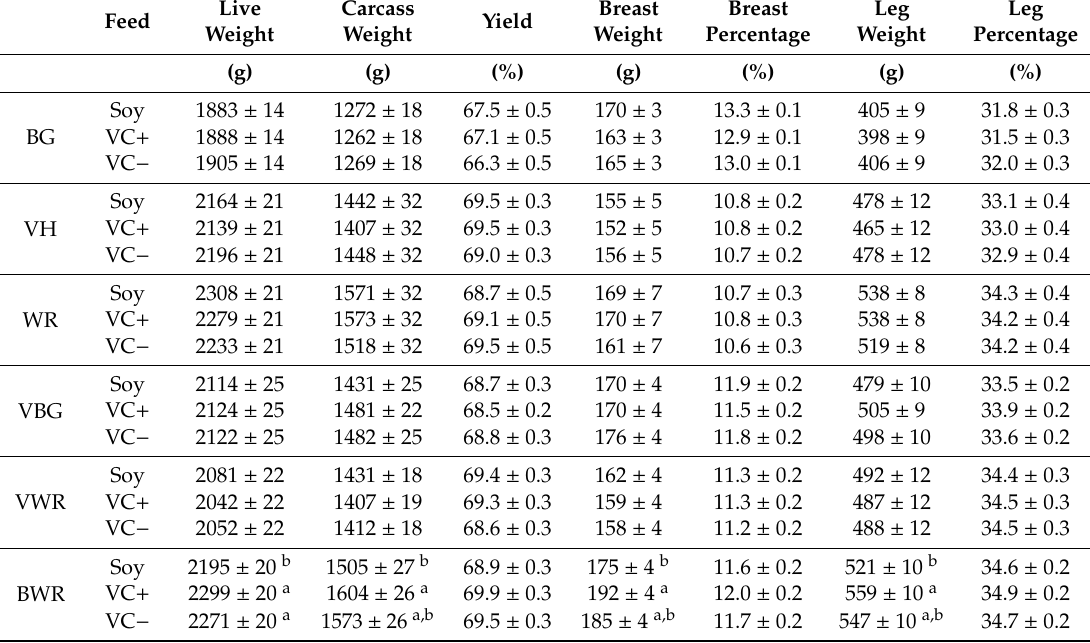
Table 6. E ff ect of feeding treatment on live weight at slaughter and carcass